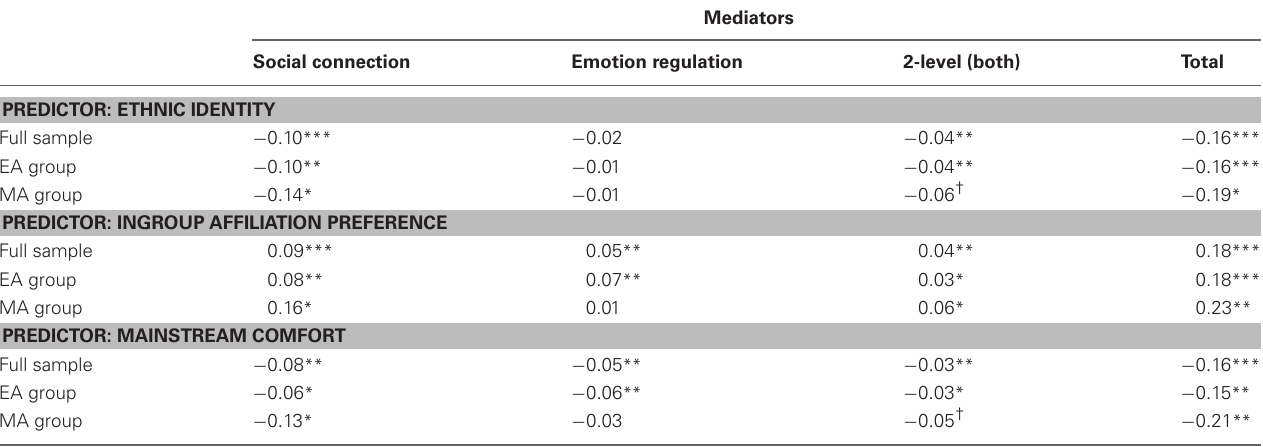
Table 5 | Standardized path coefficient estimates for model 3 indirect effects on depressive symptoms.